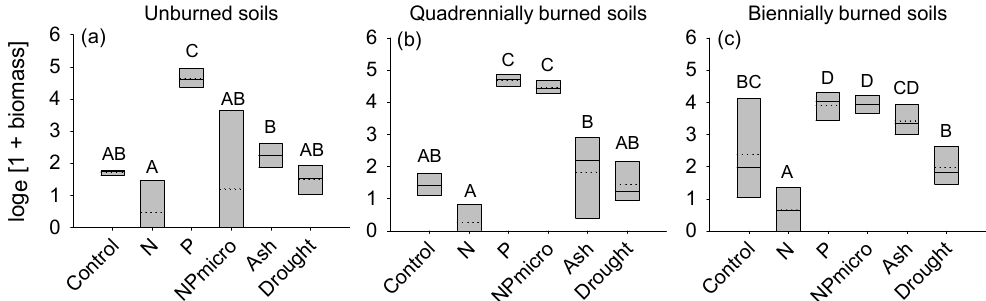
Figure 4. Box-plots showing log-transformed Imperata cylindrica biomass (log e [1 + x mg of dry biomass per plant]) gain over the 219-day growth trial compared among each level of resource amendment in ( a ) soils that have not been exposed to fire since 1969, ( b ) soils that have been exposed to surface fire every four years, on average, since 1972, and ( c ) soils that have been exposed to surface fire every two years, on average, since 1972 ( n = 4 for each fire regime x resource amendment combination; total number of observations = 72); control = no resource amendment; N = nitrogen addition; P = phosphorus addition; NPmicro = addition of N, P, and micronutrients together; ash = simulated ash deposition treatment; drought = treatment with lower levels of soil moisture); the F -statistic and p -value indicate the significance of the fire regime × resource amendment interaction term in a Gaussian-distributed linear model of I. cylindrica biomass. Means of each level of resource amendment were compared within fire regimes using ‘simple main effect tests’ ( d.f. error = 54 in all cases) based on the Least Significant Difference method in the ‘emmeans’ R package.